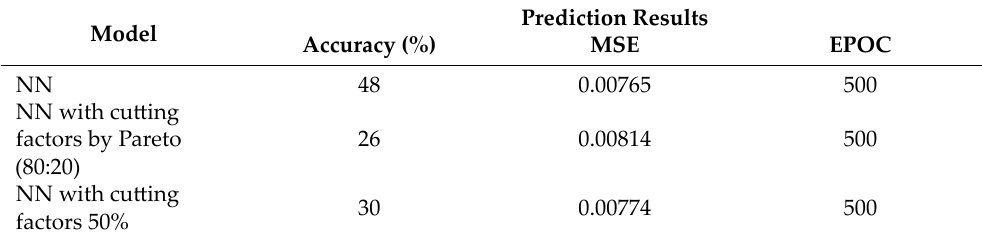
Table 6. Summarized models predicting the structure.